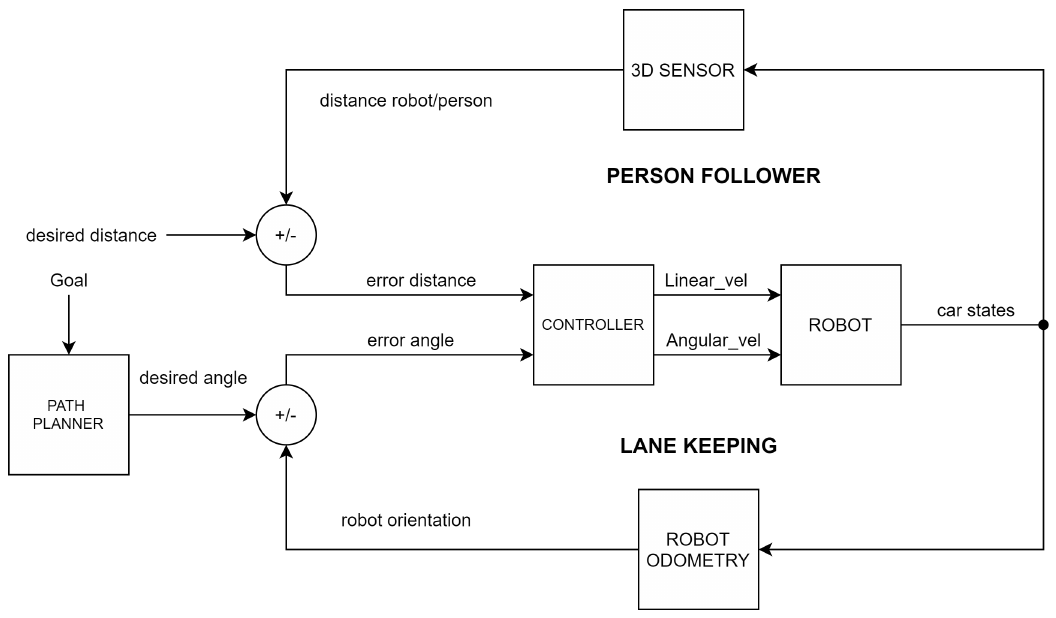
Figure 5. Person-tracking and lane-keeping